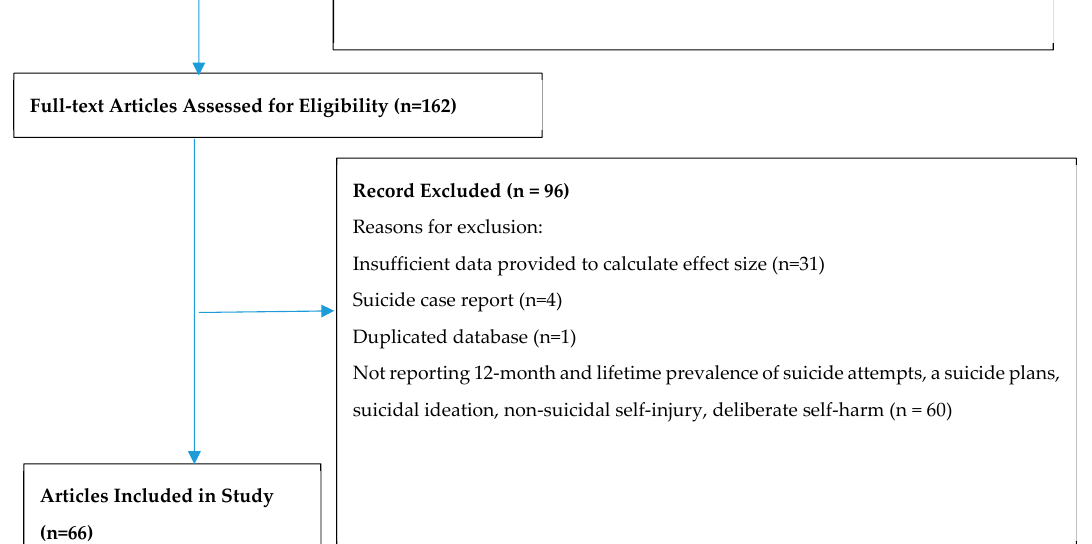
Figure 1. Process of systematic selection using the Preferred Reporting Items for Systematic Reviews and Meta-Analyses flow chart.